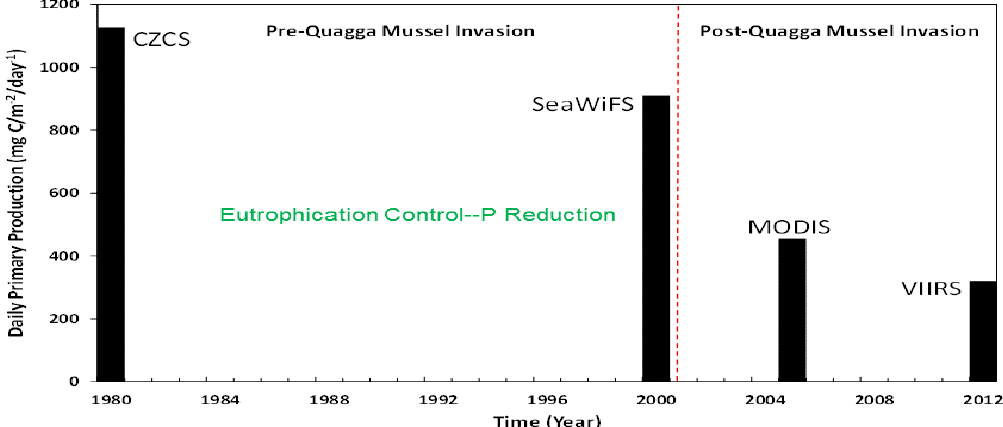
Figure 7: Average daily primary production for Lake Michigan at select time points since 1980.